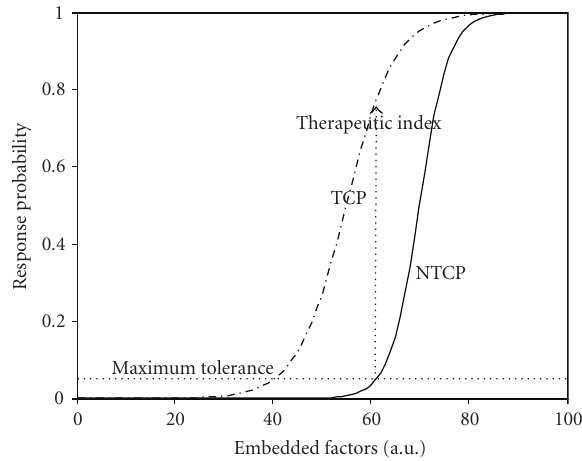
Figure 1: An S-shaped response curves representing tumor control probability (TCP) and normal tissue complication probability (NTCP) postradiotherapy as a function of treatment factors. The probabilities could be constructed as a function of heterogeneous variables (dose-volume metrics, biomarkers, and clinical factors). The radiotherapy treatment objective is to maximize the therapeutic index for each patient case.